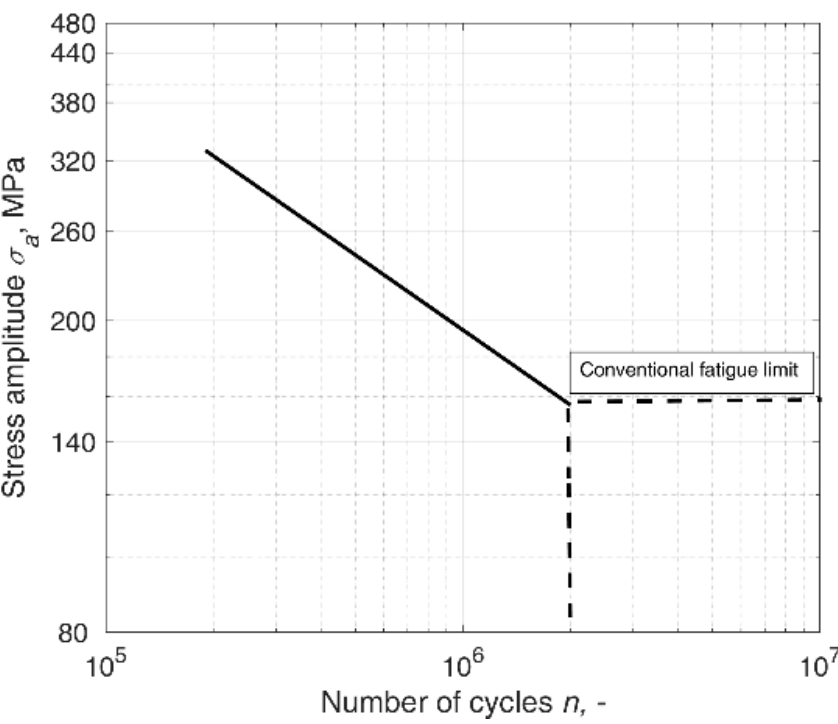
Figure 1. An example of an s-n curve. The s-n curve is also being used in models based on isodamage lines (e.g., by Sub-